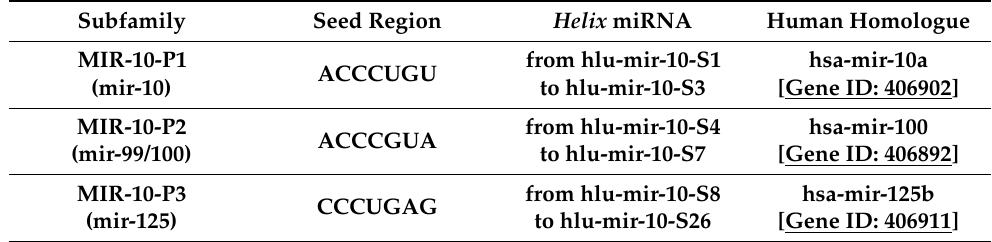
Table 1. MiRNA superfamily MIR-10 expressed in the CNS of H. lucorum and the most similar human homologues.